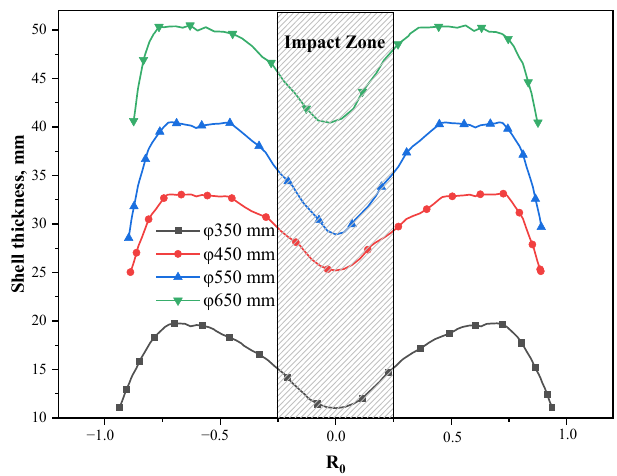
Figure 16. Circumferential shell thickness at the mold exit for different section sizes.